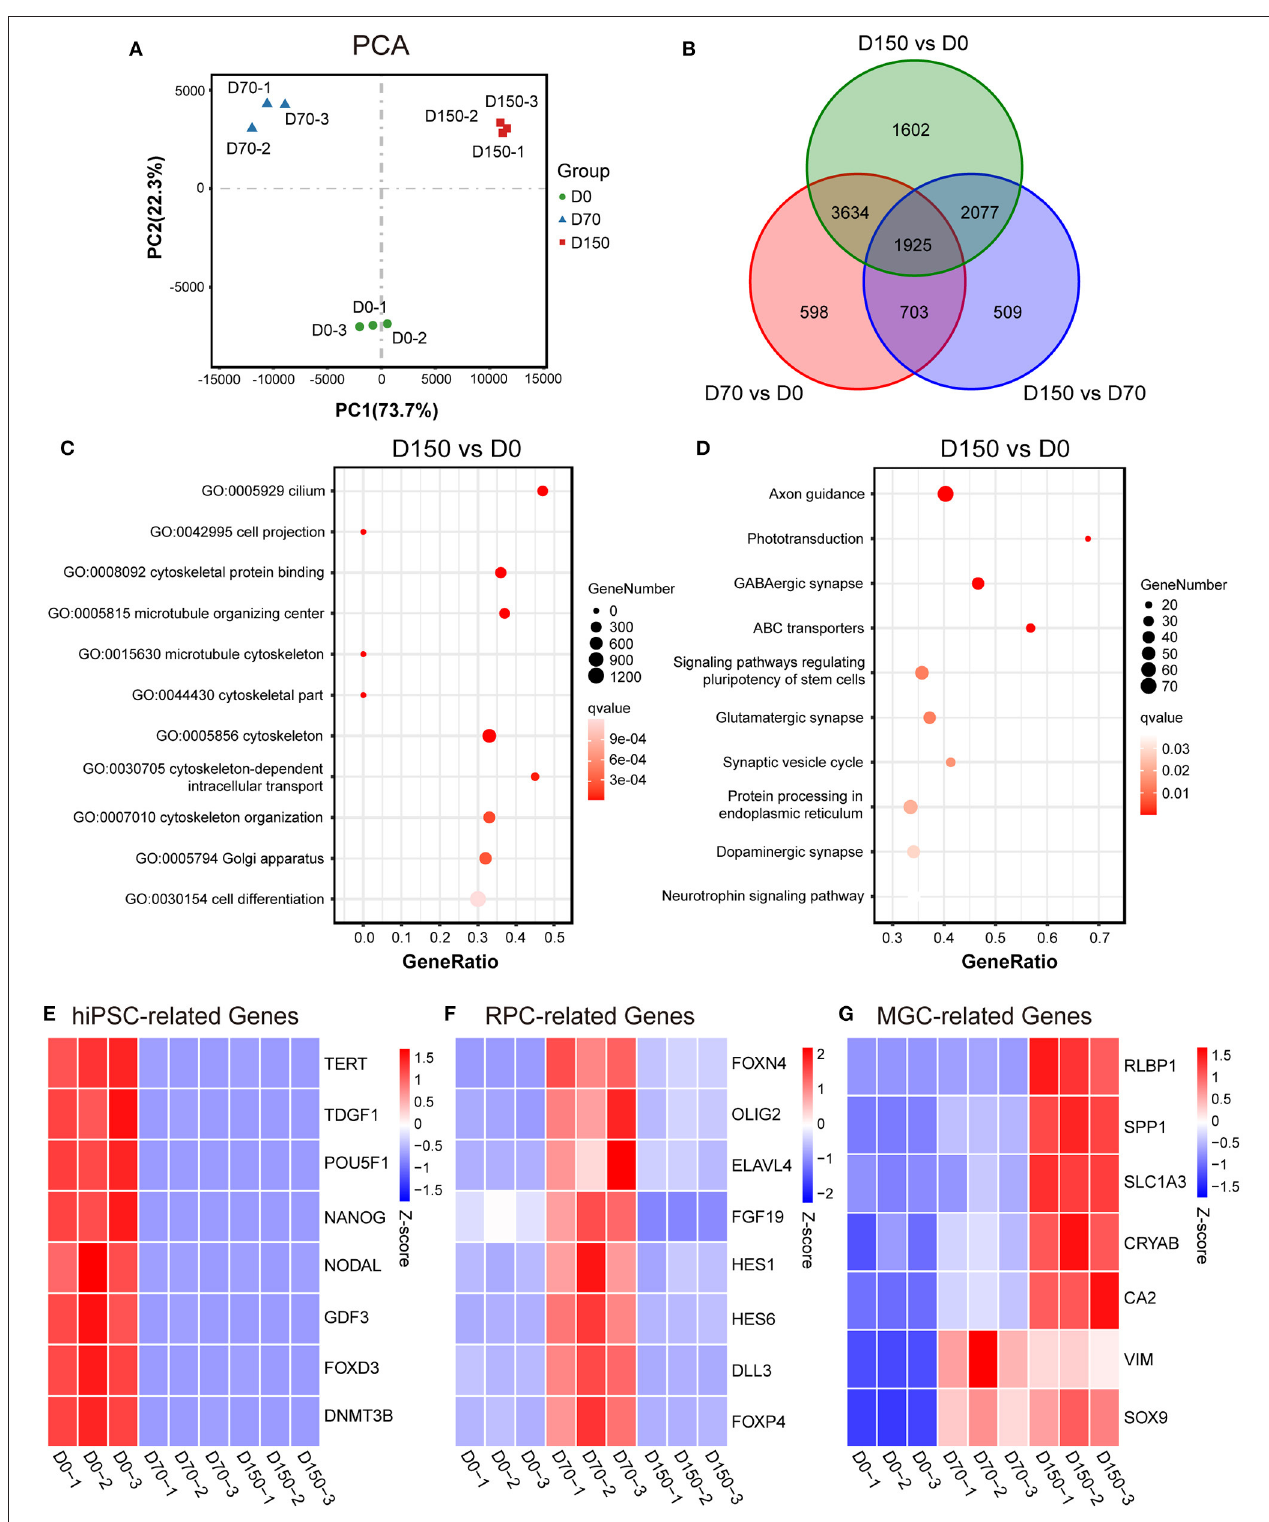
FIGURE 2 | RNA-seq analysis of MGC development in ROs at different stages. (A) Principal components analysis (PCA) showed a comparison of the transcriptome data in hiPSCs (D0) and ROs at different stages. (B) Venn diagram showed the number and overlapping relations of the differentially expressed genes (DEGs) among hiPSCs and ROs at different stages. (C) Dot plot showed Gene Ontology (GO) analysis of the upregulated DEGs of D150-ROs comparing to hiPSCs; GO terms with